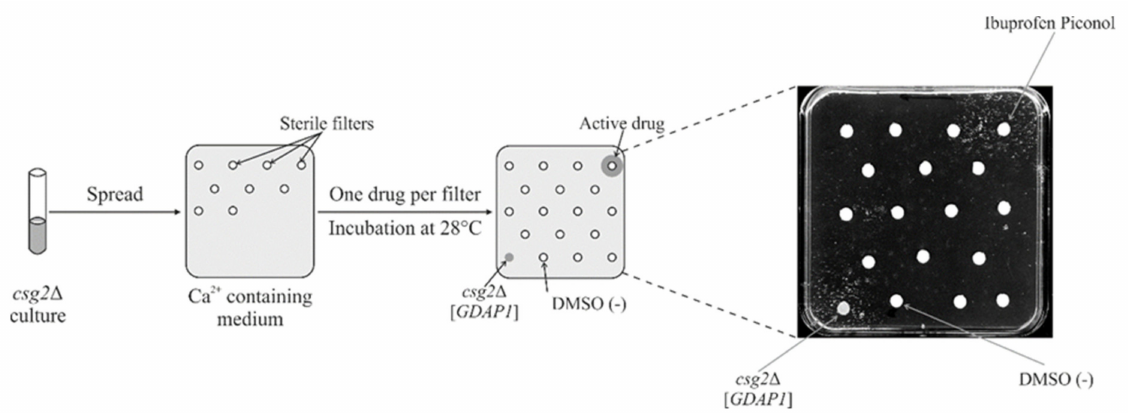
Figure 8. Ibuprofen piconol is a chemical suppressor of the csg2 ∆ growth defect on media supplemented with Ca 2+ ions. The csg2 ∆ cells were plated on YPD + 0.5 M CaCl 2 . Compounds from the Prestwick library were applied on filter discs (2 µ L of 10 mM solution in DMSO). DMSO, a solvent, was used as a negative control. The csg2 ∆ [ GDAP1 ] strain was spotted as a positive control. Plates were incubated for 3–5 days at 28 ◦